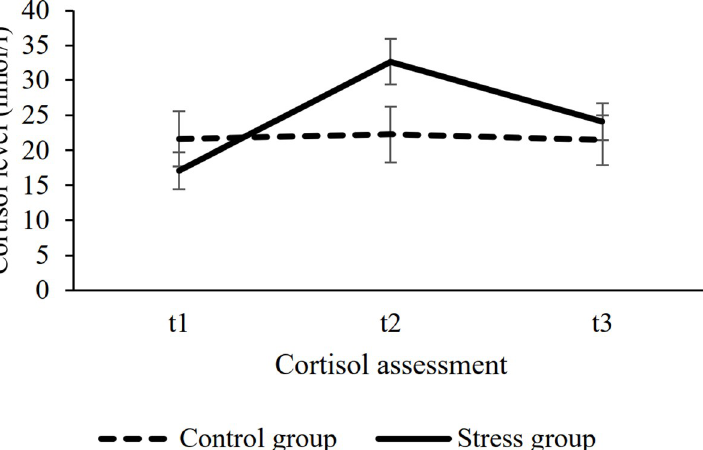
Fig 3. The effectiveness of stress induction. Salivary cortisol levels were assessed immediately before (t1), 15 minutes after (t2), and 45 minutes after (t3) the stress induction or control task. Error bars denote the standard error of the mean (SEM).